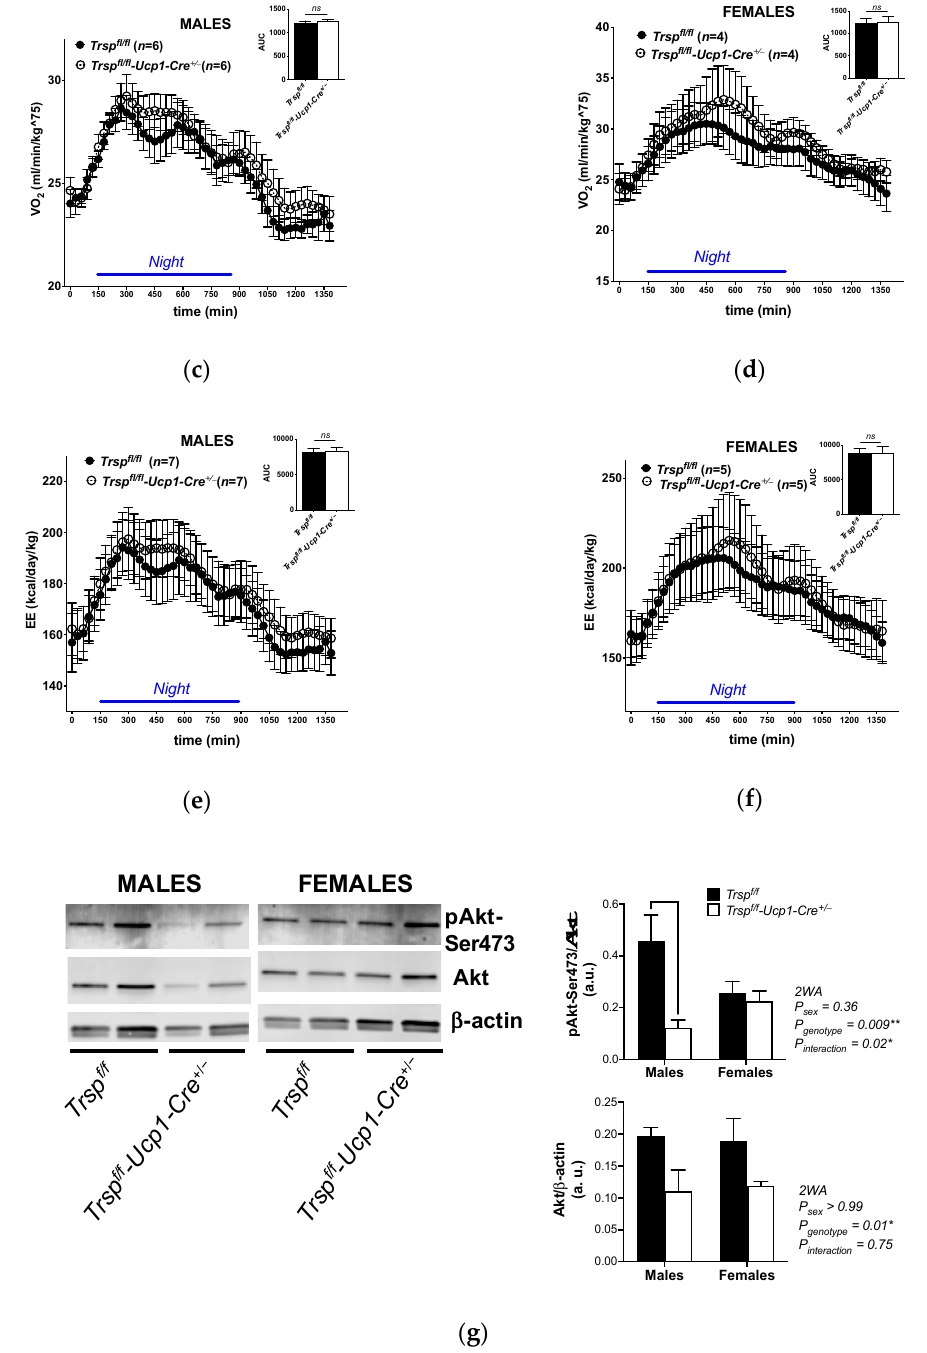
Figure 2. Metabolic overview of Trsp f/f -Ucp1-Cre +/ − mice. Body weight assessment of male ( a ) and female ( b ) Trsp f/f -Ucp1-Cre +/ − mice over 8 weeks after weaning. ( c , d ) VO 2 consumption in male and female in the Trsp f/f -Ucp1-Cre +/ − mice, respectively. ( e , f ) Energy expenditure calculations of male and female mice, respectively, considering VCO 2 as well (VCO 2 not shown). ( g ) Phosphorylated Akt at the Ser473 residue (pAkt-Ser473) and Akt levels in the gonadal WAT of male and female mice. Values are means ± SD. p -values were calculated in ( a , b , g ) after two-way ANOVA (2WA) followed by Bonferroni’s post-test, while for ( c – f ), p -values for the area under the curve (AUC) were calculated using Student’s t -test. The sample size is displayed in graphs, except in ( g ), where n = 6/sex. * p < 0.05, ** p < 0.01, and ns , non-significant. Black bars are Trsp f/f mice, and white bars are Trsp f/f -Ucp1-Cre +/ − mice.